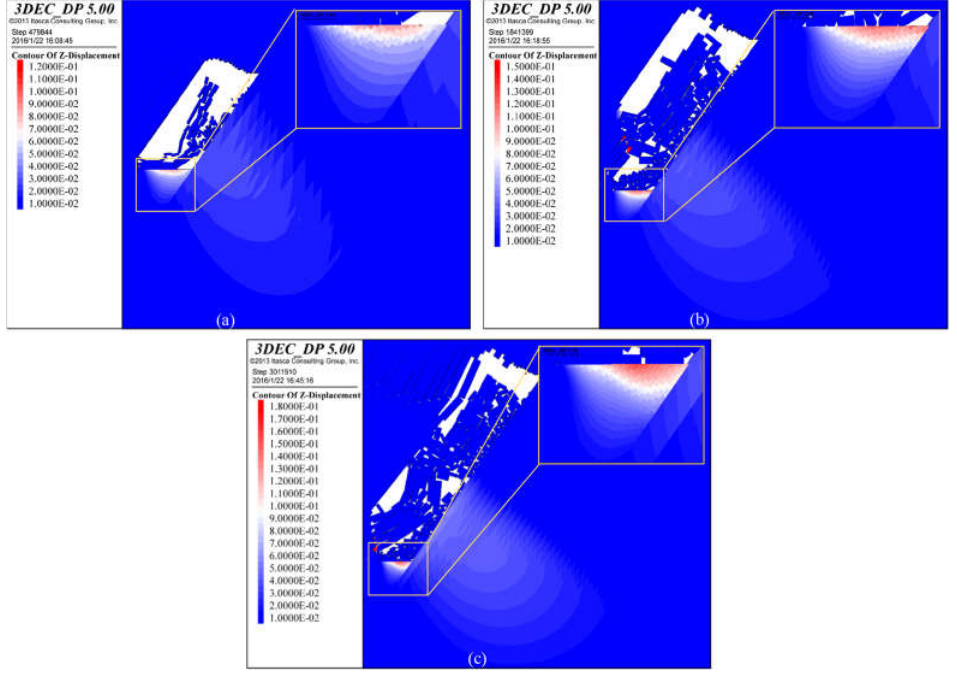
Figure 10. The expansion deformation cloud charts in the coal below the goaf: ( a ) the 5th slice; ( b ) the 10th slice and ( c ) the 15th slice.